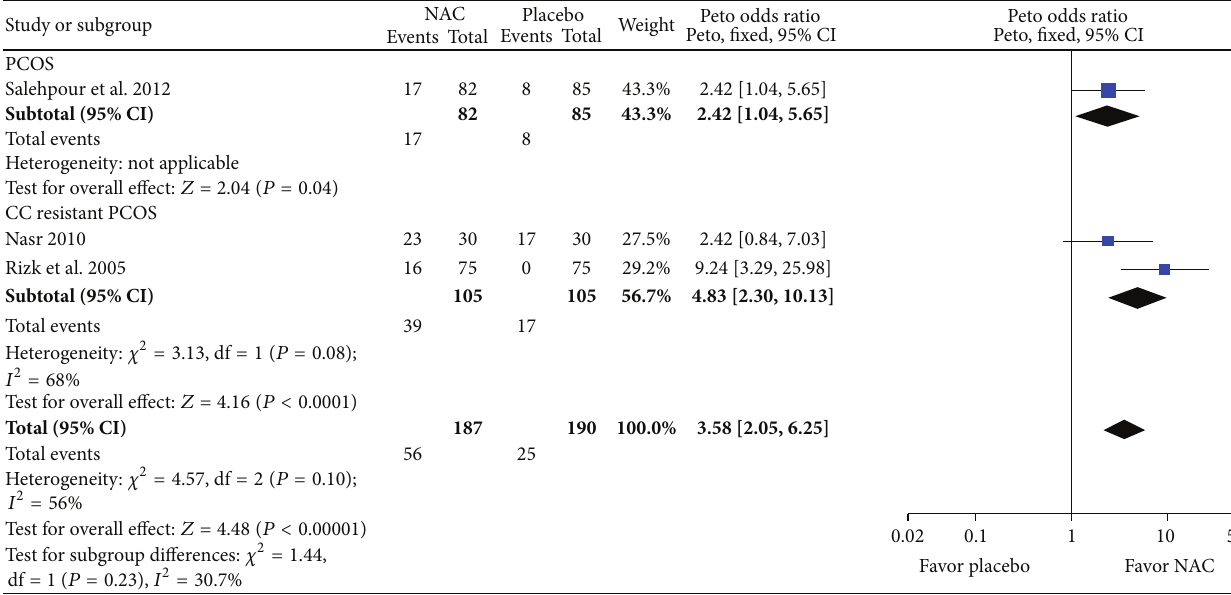
Figure 4: Forest plot: outcome: pregnancy rate in women with PCOS comparing NAC with placebo.